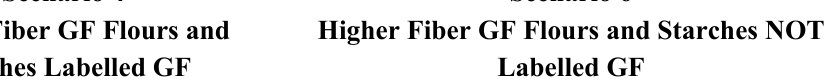
Table 7. Estimated percentiles of gluten exposure (mg/day) in different age-sex groups when many grain-containing foods are prepared at home using higher fiber GF flours and